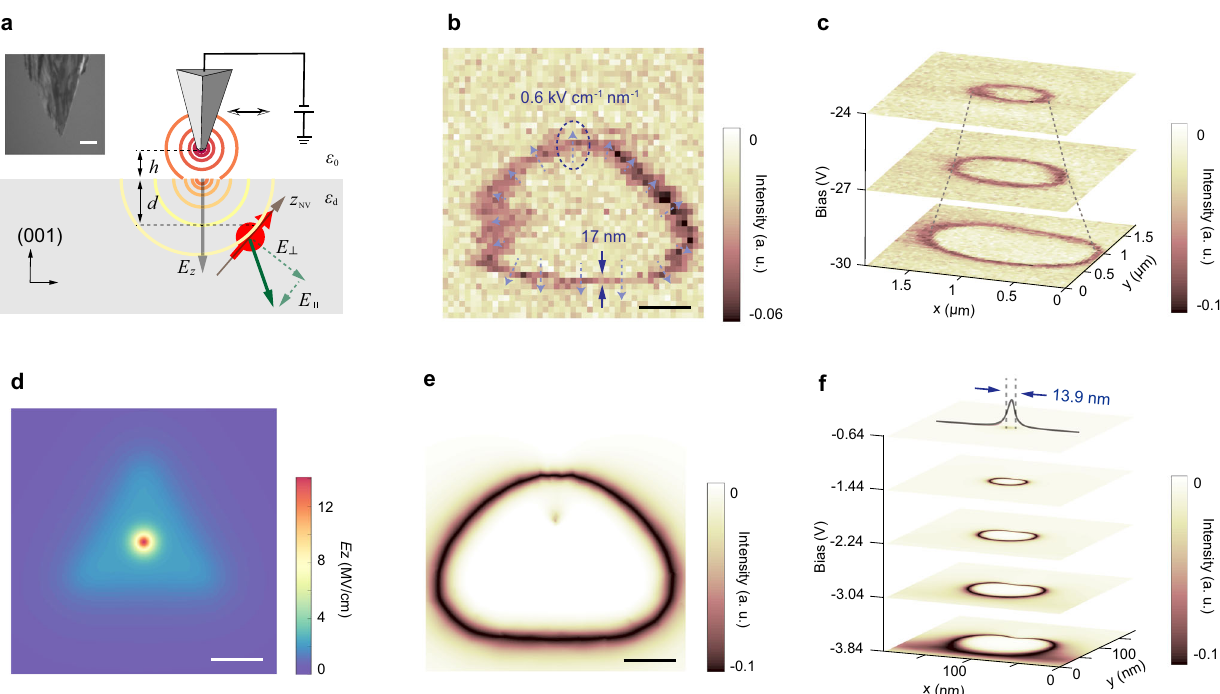
Fig. 2 NV-based nanoscale scanning electrometry and quantitative estimation. a Schematic graph showing the simple triangular-tip model with a spherical tip apex. E ? and E k (green lines) are projected onto a NV with a depth of d at a tip height of h . During the simulation, we set ε d = 5.7 for diamond material. Inset: Scanning electron microscope (SEM) image of FIB-treated tungsten tip. Scale bar: 1 μ m. b Scanning fi eld-gradient imaging obtained at − 16V with ODMR setpoint of 700kHz. The dashed arrows re fl ect the direction and magnitude of fi eld gradient. c Scanning fi eld-gradient imaging of the tip under different biases. AFM setpoint: 4 f AFM = + 10Hz. Pulsed-ODMR setpoint: 4 f = 400 kHz. d Simulated fi eld distribution along the surface normal ( E z ) from the triangular-tip model ( a ) with a side length of 220nm, apex radius of 30 nm, h = 1 nm, d = 5 nm and bias = − 150 V. A fi eld strength as large as 14.1 MVcm − 1 can be experienced by the NV. e Simulated scanning- fi eld gradient image at the bias = − 10V. The ODMR setpoint is set to be 700 kHz. The non-spherical shape arises from both the triangular tip and the fact that NV axis is not perpendicular to diamond surface. Scale bars in b , d , and e are 100 nm. f A series of simulated scanning gradient- fi eld images under the same geometric parameters as in ( e ), demonstrating a precision of 13.9nm for positioning the NV